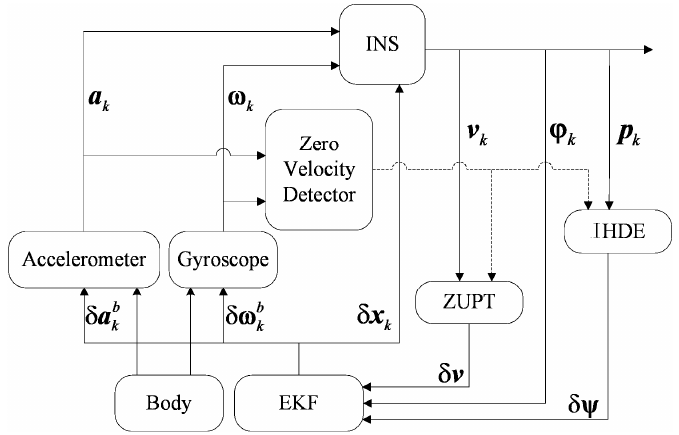
Figure 1. Pedestrian Dead Reckoning (PDR) implementation scheme.